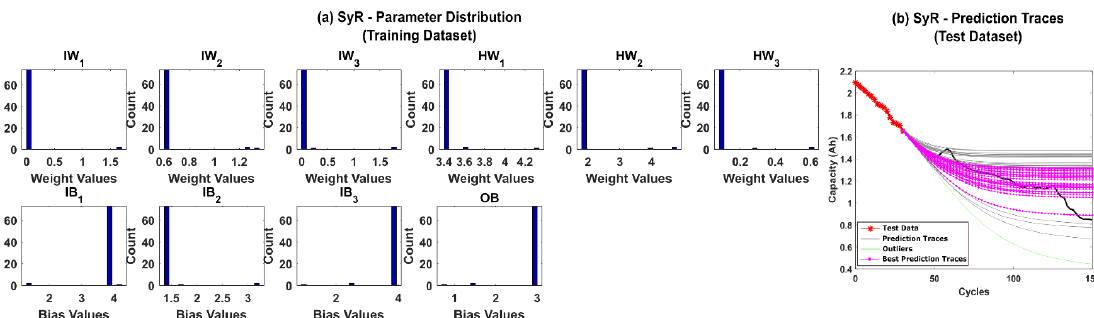
Figure 13. ( a ) The posterior distribution of MLP network parameters estimated by the adaptive Bayesian learning framework using SyR and ( b ) the degradation prediction traces for NASA battery (RW-11) using SyR. The prediction traces for 50 repetitions are shown using the gray lines, the green lines represent outliers, and the magenta lines represent the traces with minimum RMSE values.